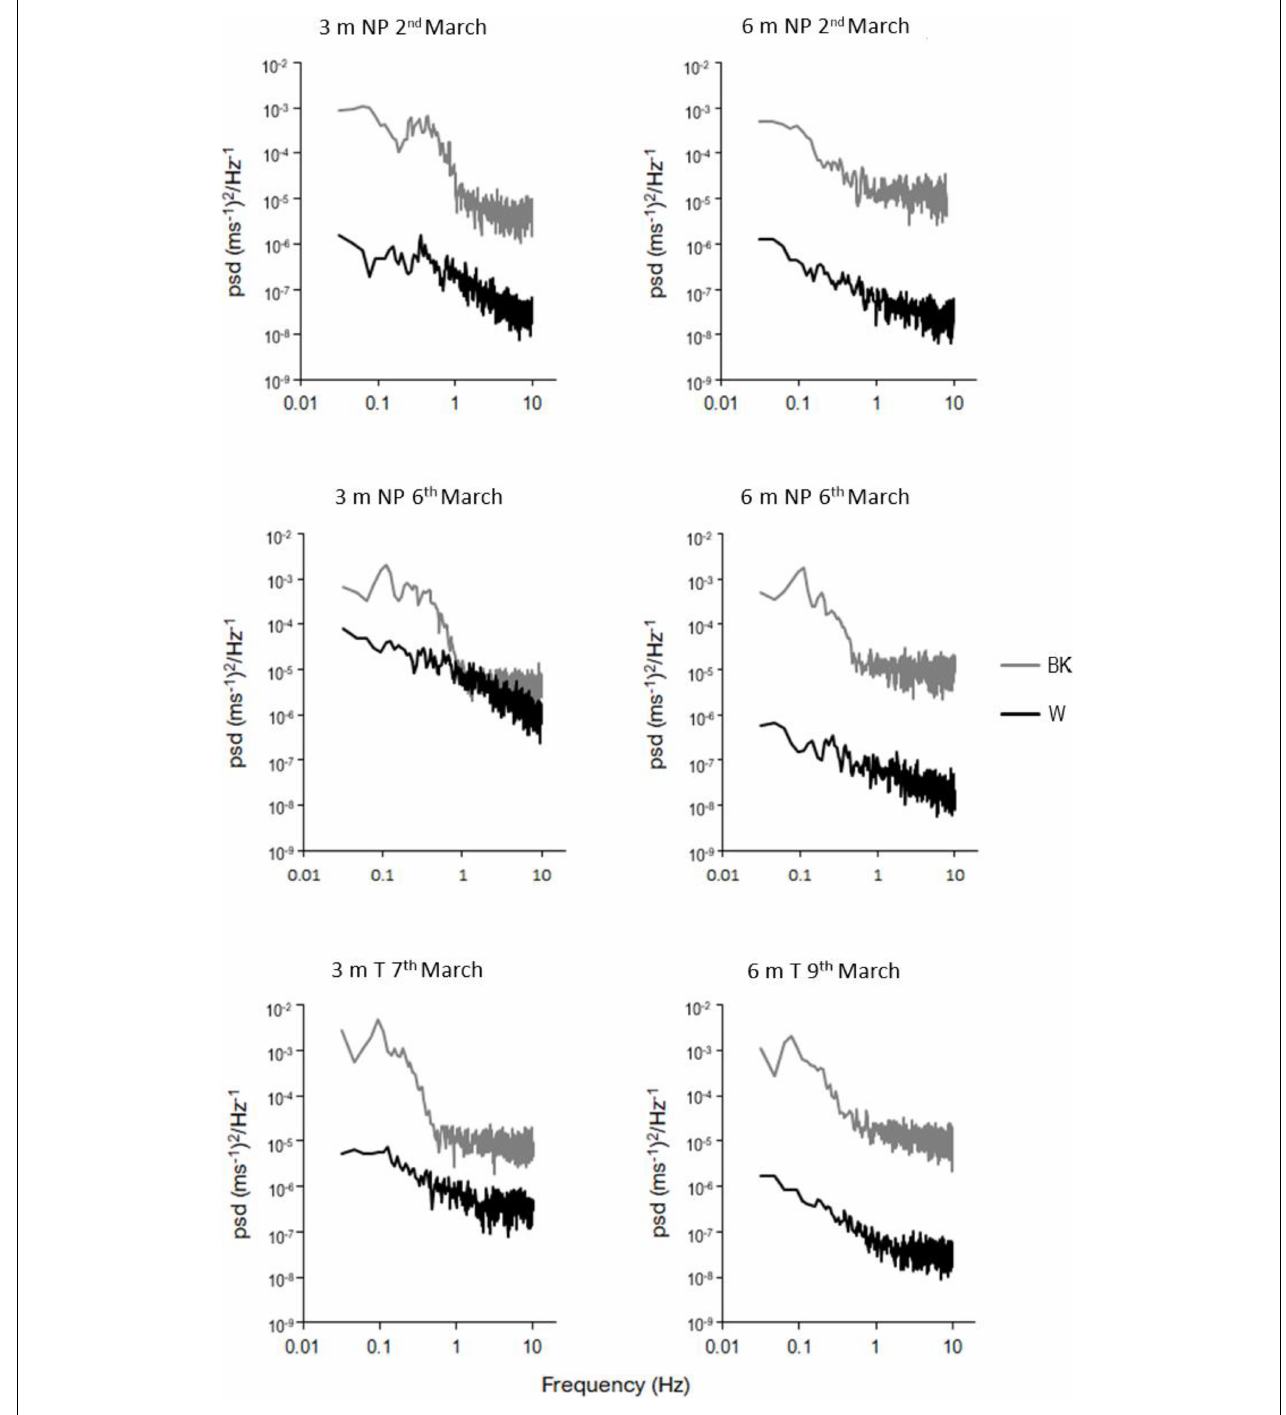
FIGURE 3 | A selection of power spectral density (PSD) plots of speed ( U ) for background (BK) and within canopy (W) measurements at 3 and 6 m depth at Ninepin Point (NP) Tinderbox (T).